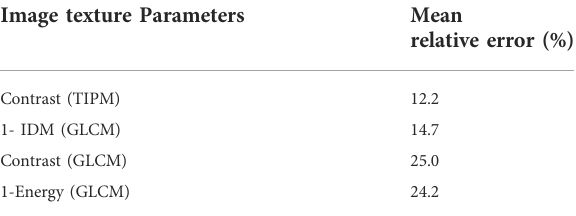
polarization texture